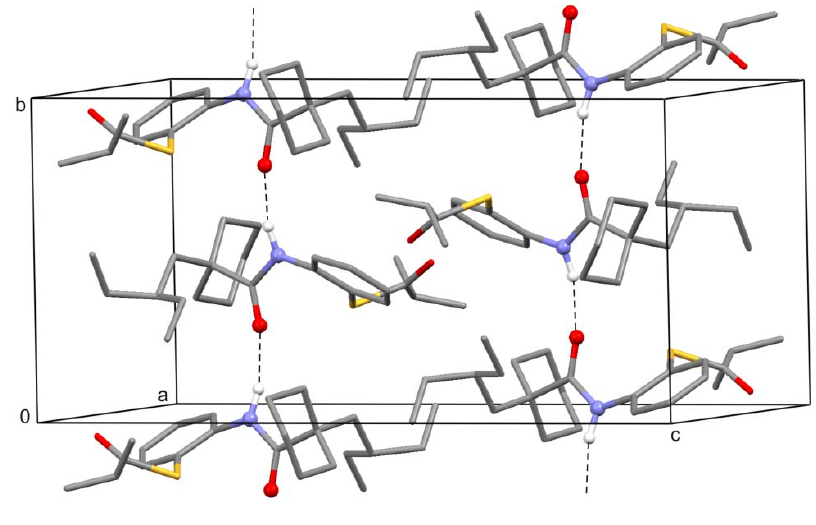
Figure 3. Packing diagram of dalcetrapib (3). Atoms engaged in hydrogen bonding are drawn as balls, and all other hydrogen atoms are omitted for